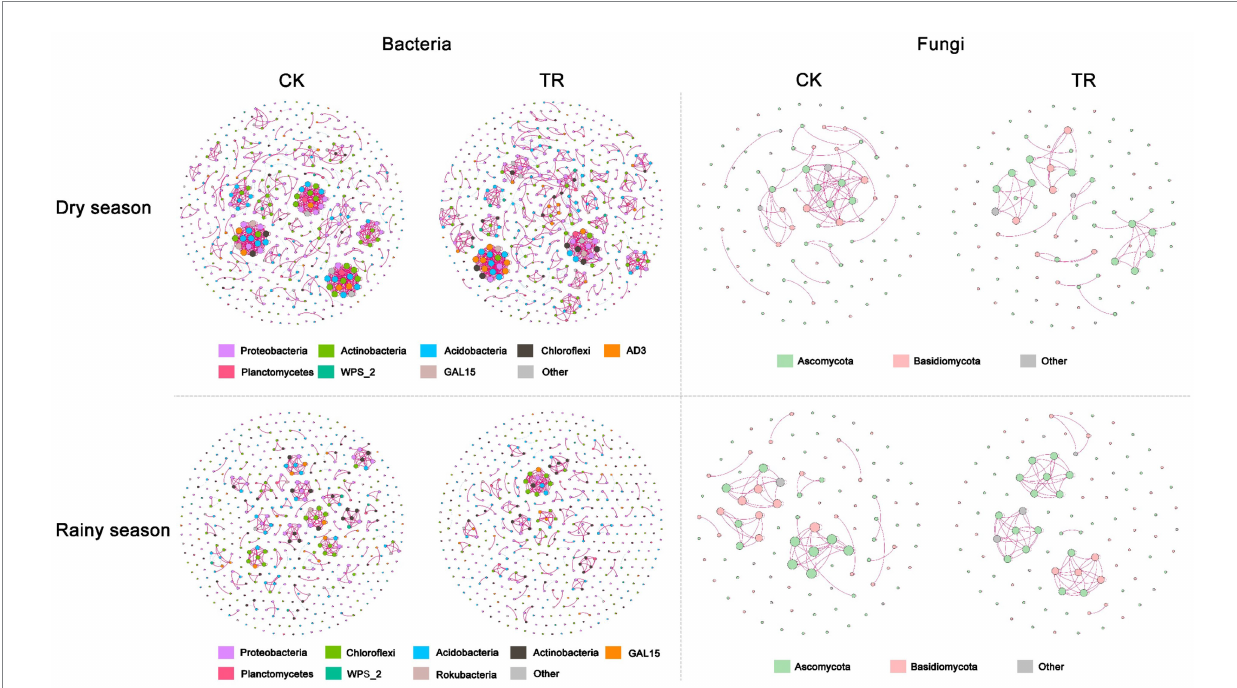
FIGURE 6 Bacterial and fungal networks under CK and TR treatment in dry and rainy seasons. Both soil depths were used to perform these co-occurrence network analyze. Only Spearman’s correlation coefficients where r > 0.7 or r < − 0.7 (significant at p < 0.05) are shown. The nodes are colored according to phyla. Positive correlations are indicated by red borders, whereas negative correlations are indicated by blue edges. Node size is proportional to the betweenness centrality of each ASV, and edge thickness is proportional to the weight of each